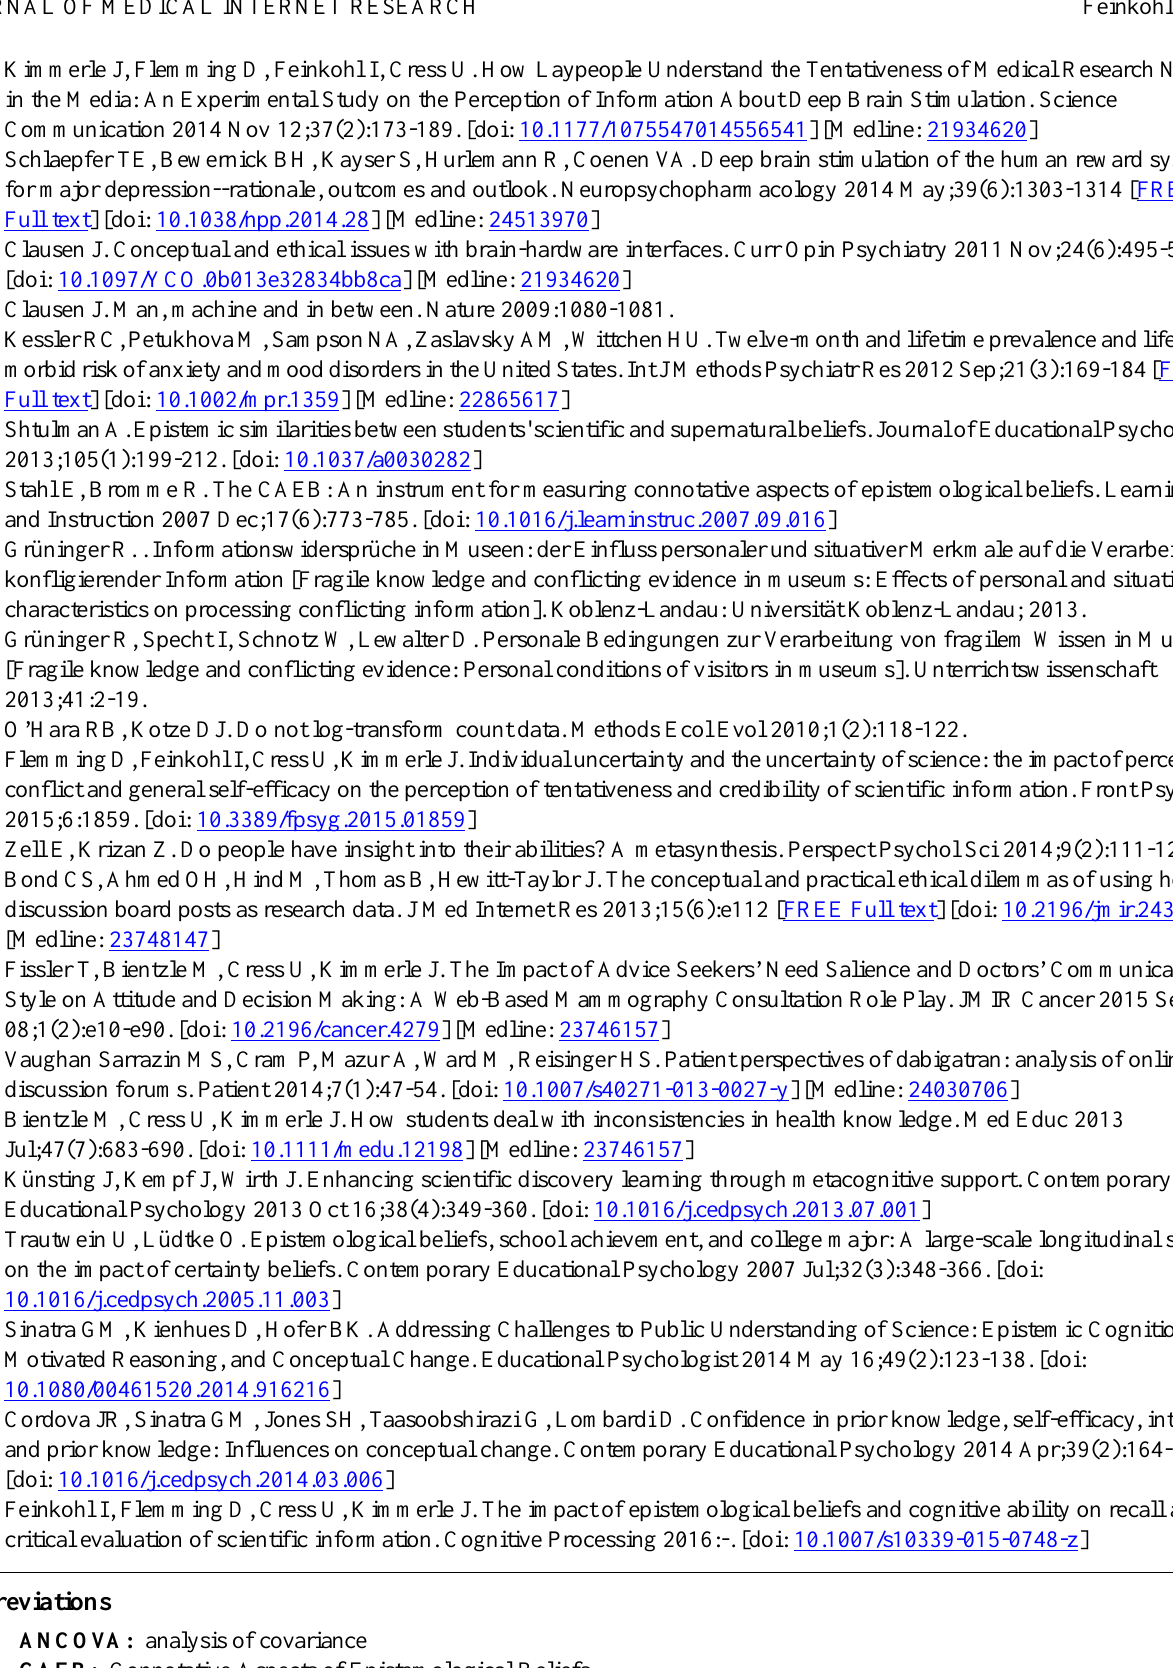
Abbreviations ANCOVA: analysis of covariance CAEB: Connotative Aspects of Epistemological Beliefs DBS: deep brain stimulation NoS: Nature of